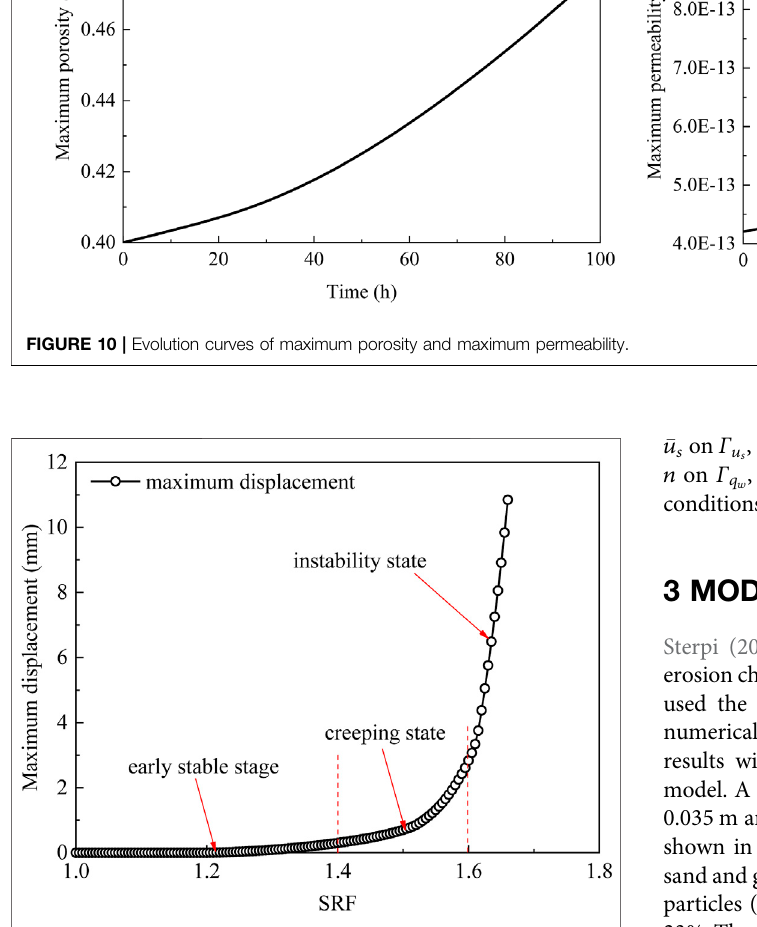
FIGURE11| Variationdiagramofmaximum